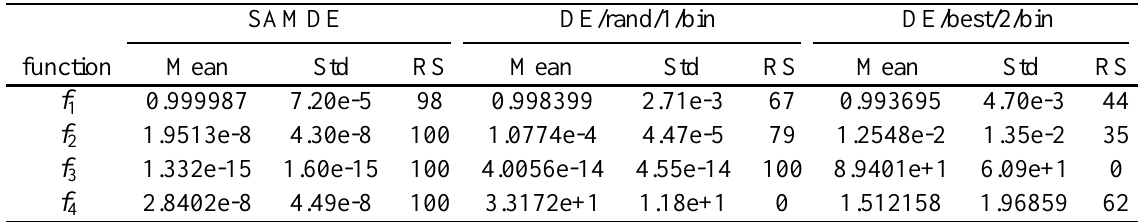
Table 1. Average results and rate of successful optimization of 50 independent